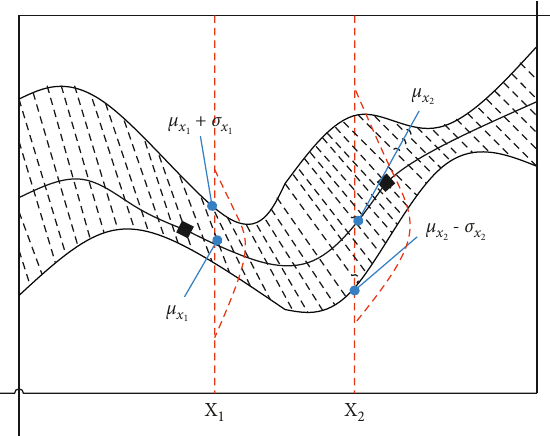
Figure 1: One-dimensional Gaussian